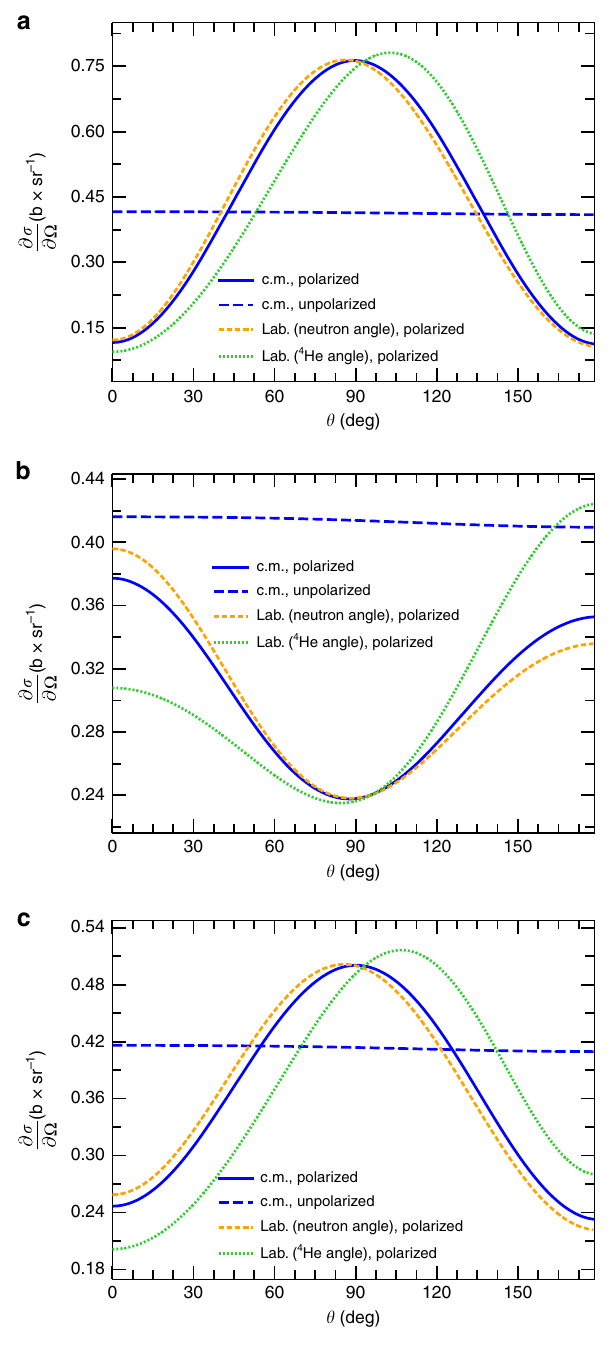
(cid:1) (cid:3) . Fig. 6 Present results for the polarized DT differential cross section ∂ σ ∂ Ω Three polarization scenarios are shown: a With reactants ’ polarization ; p parameters p 0 : 8, and q 0 : 8; b with spins prepared in an z zz ¼ z ¼ antiparallel setting p 0 : 8 ; q 0 : 8 and p 0 : 8 ð Þ ; and c in the z ¼ z ¼ (cid:4) zz ¼ scenario in which only the deuterium is polarized p 0 : 8 and p 0 : 8 ð Þ . z ¼ z ¼ The incident deuterium energy is 100 keV. The “ c.m., polarized ” , “ Lab. (neutron angle), polarized ” , and “ Lab. ( 4 He angle), polarized ” labels stand for the polarized differential cross section in the center-of-mass (c.m.) frame, and in the laboratory frame as a function of the neutron and 4 He angles. Correspondingly, θ stands for the c.m., neutron, and 4 He angles. Also shown as a reference is the unpolarized cross section in the